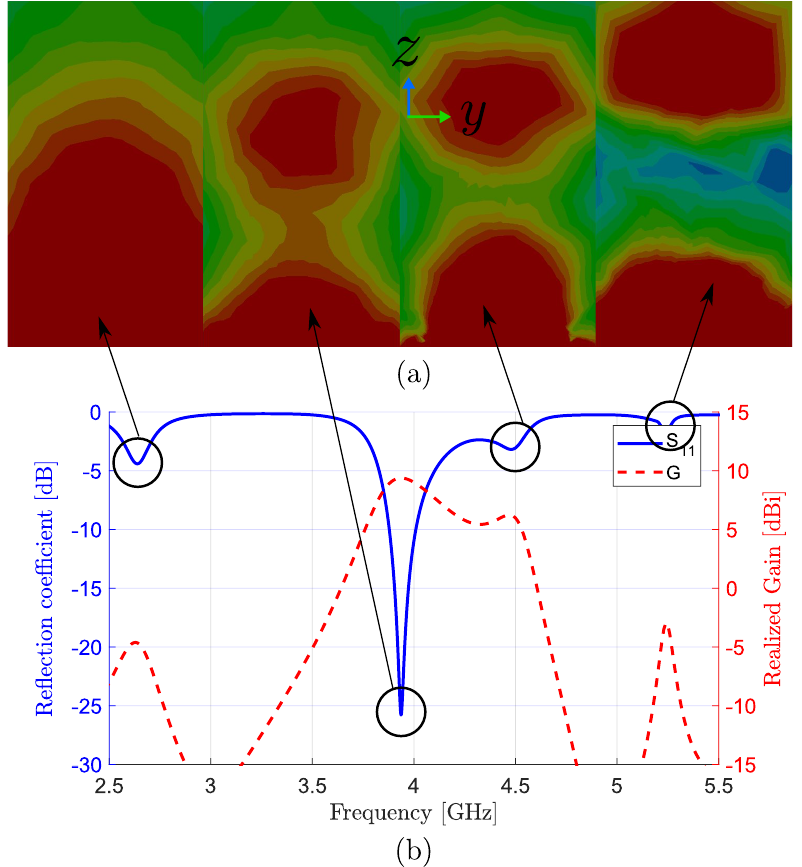
Figure 3. ( a ) Field distribution of TE 113 mode at 3.9GHz and neighboring resonant modes inside DRA. ( b ) Simulated S 11 and gain vs. frequency of antenna